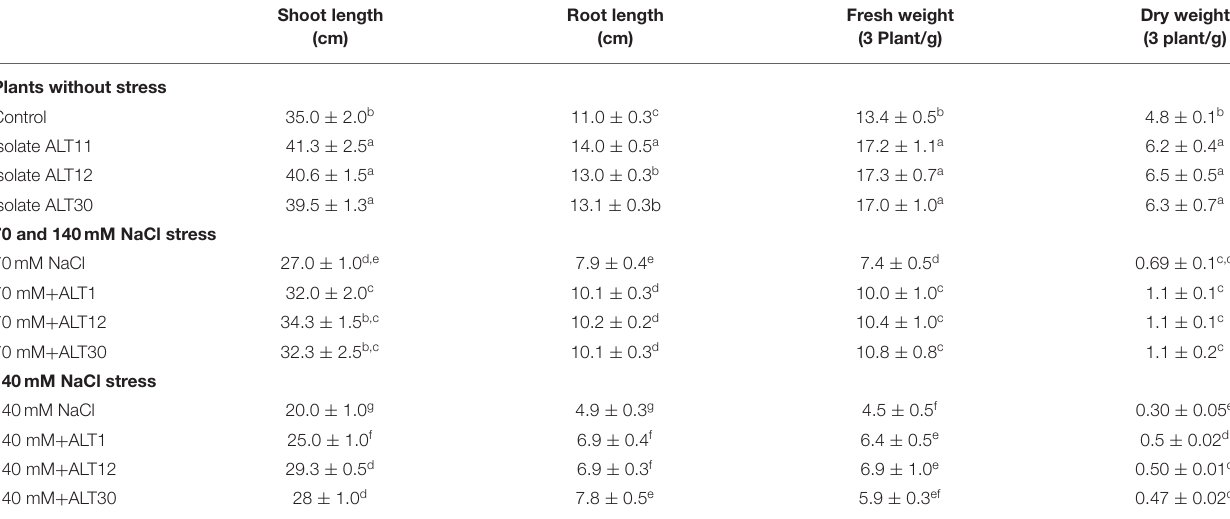
Different letters indicate significant differences between the mean values of three replicates ± standard